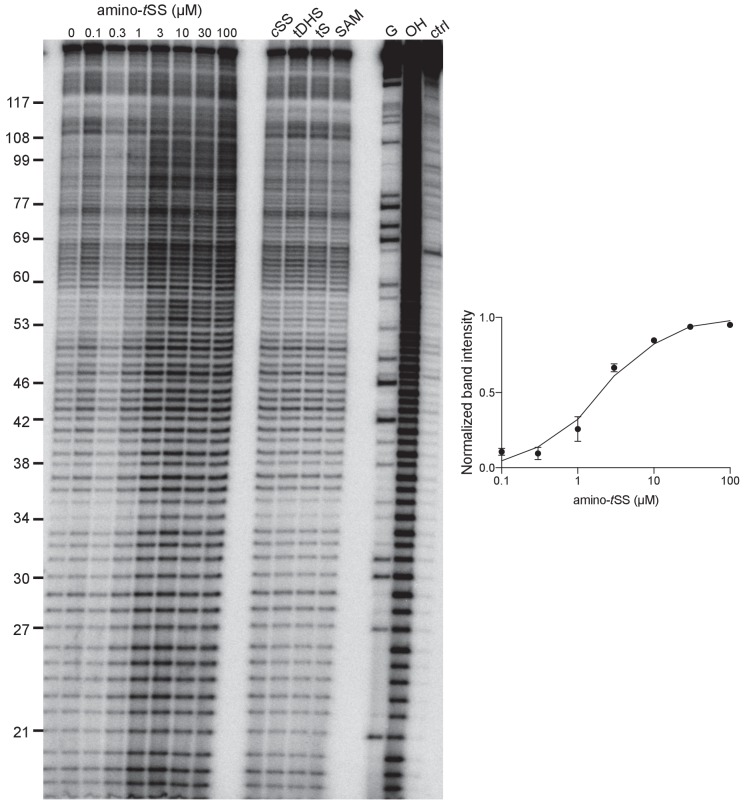
Structural probing of Were-1 in presence of amino-tSS, amino-cSS, tDHS, tS, and SAM by terbium (III) footprinting.Left lanes show RNase T1 digestion for sequence reference, and partial hydrolysis (OH). Middle lanes show Tb3+ footprinting in the presence of increasing amino-tSS at concentrations indicated above the gel image. Right lanes show control reactions with Were-1 in the presence of 30 µM controls, as labeled above the gel image. Right, a KD value of 4.8 µM was calculated based on the change in intensity with increasing amino-tSS at nucleotides A113 and U107.